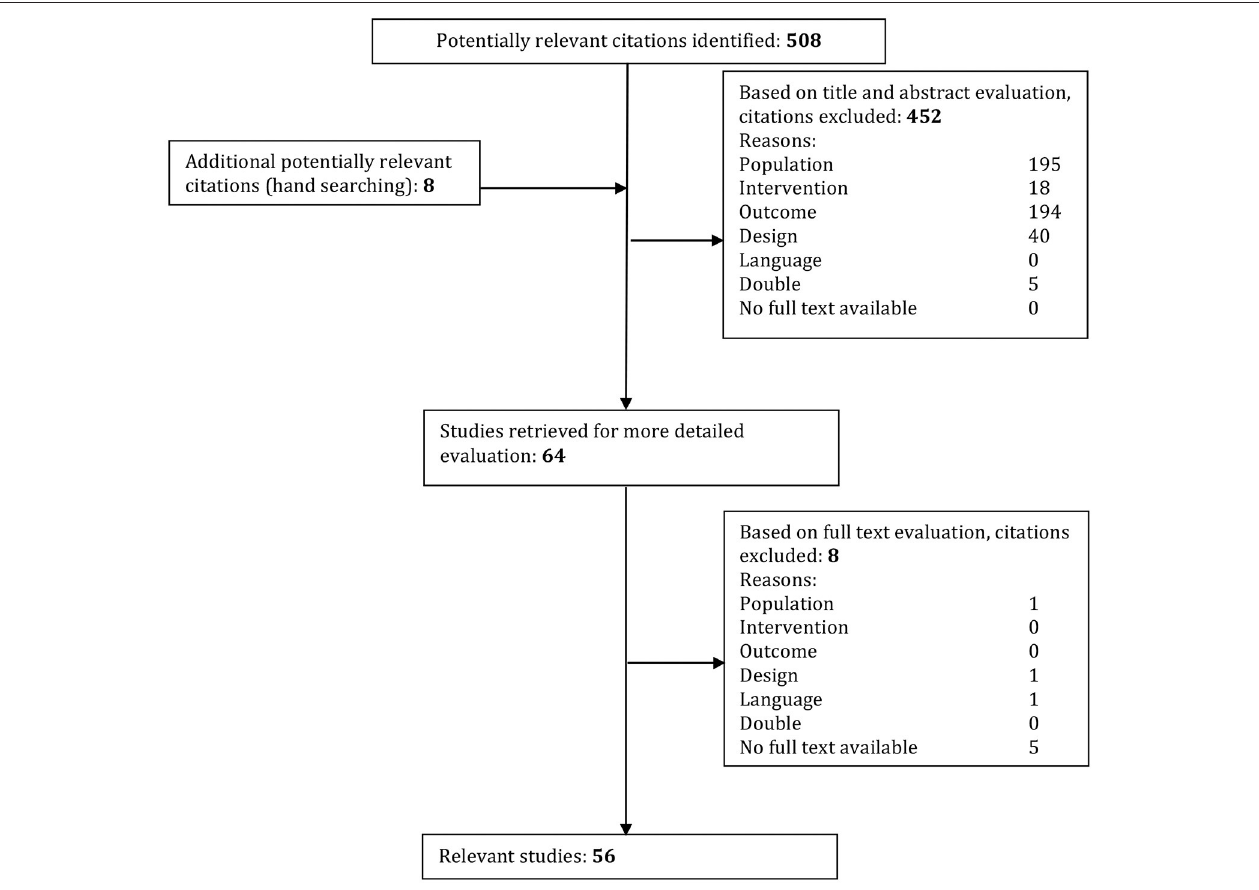
FIGURE 1 | Systematic study inclusion. Studies were excluded if they conformed to the following criteria: Population: unilateral vestibulopathy, absence of DFNA9, pathology not concerning bilateral vestibulopathy or not cause by DFNA9 mutation. Intervention, not strictly observational; Outcome, When the goal of the study was not to acquire data involving the etiology or pathophysiology; Design, Reviews and single case studies; Language, Not English or Dutch. Double, If found in more than one database that article was only used